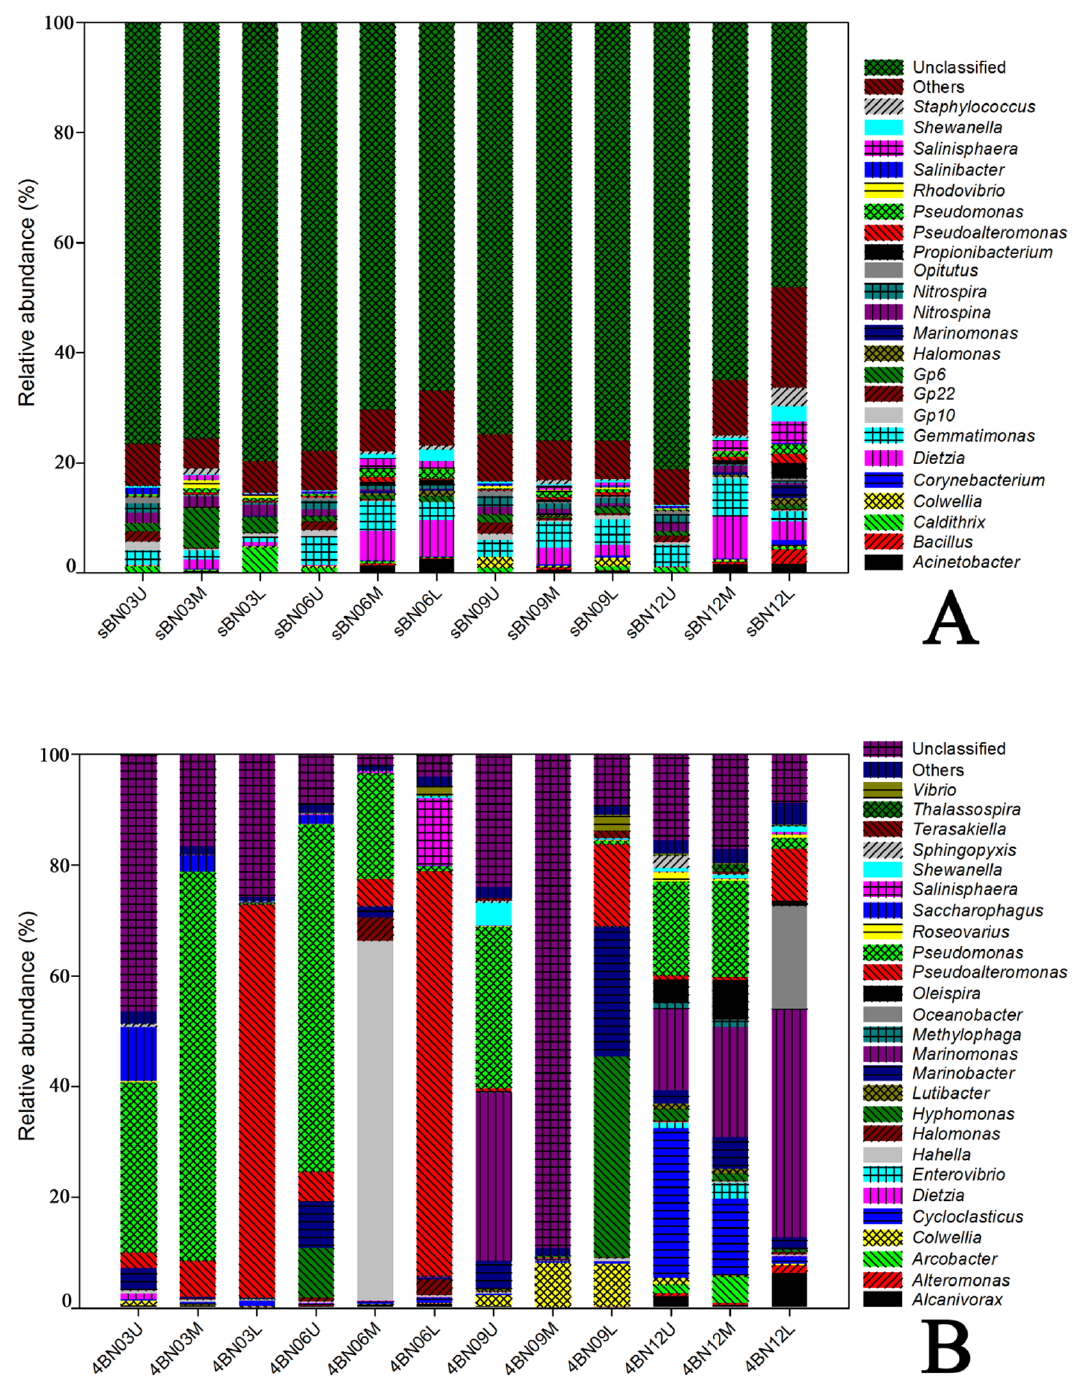
Figure 3. Relative abundances of bacteria (genus level) in the sediments and enriched consortia from the Arctic Ocean. (a) Sediment, (b) 4 ◦ C consortia, (c) 15 ◦ C consortia and (d) 25 ◦ C consortia. The genera with abundance of more than 1% of the total tags in at least one consortium are listed in each plot. “Others” refers to the genera constituting less than 1% of the total tags of a sample for all